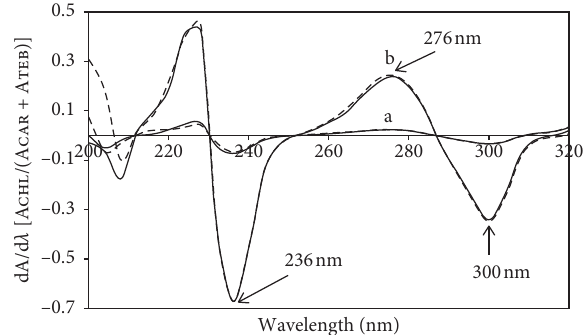
Figure 4: The coincident spectra of the first derivative of the ratio spectra of (a) 5 μ g/mL pure CHL ( ___ ) and 5 μ g/mL CHL in a ternary mixture (-----), and (b) 50 μ g/mL pure CHL ( ___ ) and 50 μ g/ mL CHL in a ternary mixture (-----) in methanol using 5 μ g/mL CAR +5 μ g/mL TEB as a double divisor at Δ λ � 4.